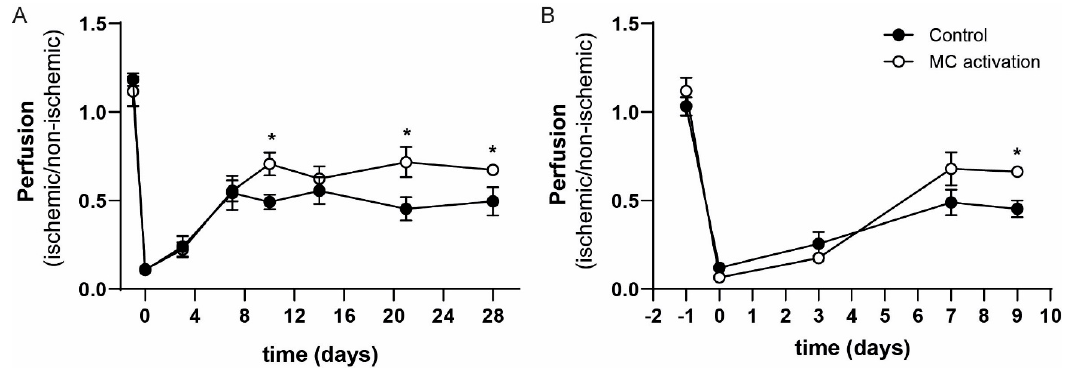
Figure 3. Perfusion of the ischemic hind limb in mast cell (MC) activated vs. control mice. Perfusion (ischemic/non-ischemic) as measured by Laser Doppler Perfusion Imaging (LDPI) from day 0 to day 28 in the long-term experiment ( A ) and in the short-term experiment from day 0 up to day 9 ( B ) after ligation of the femoral artery. * p -value of < 0.05 between the groups.